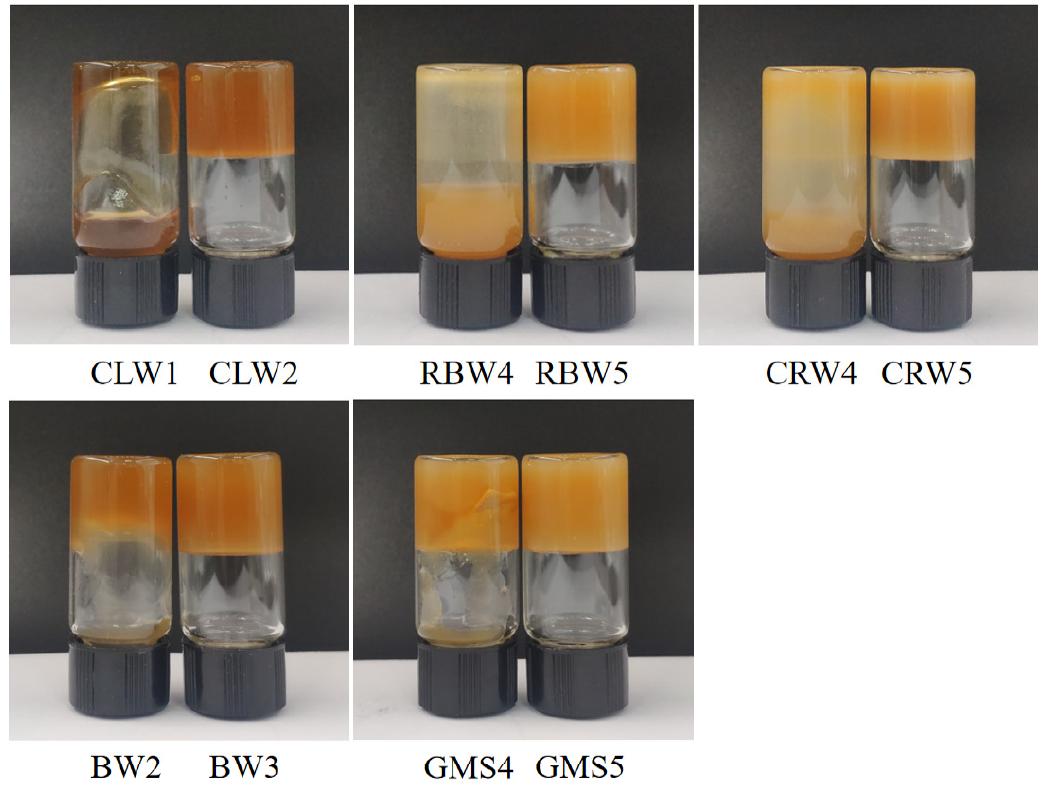
Figure 1. Determination of critical concentration of different types of oleogel (wt.%). CLW, candelilla wax; RBW, rice bran wax; CRW, carnauba wax; BW, beeswax; GMS, glycerol